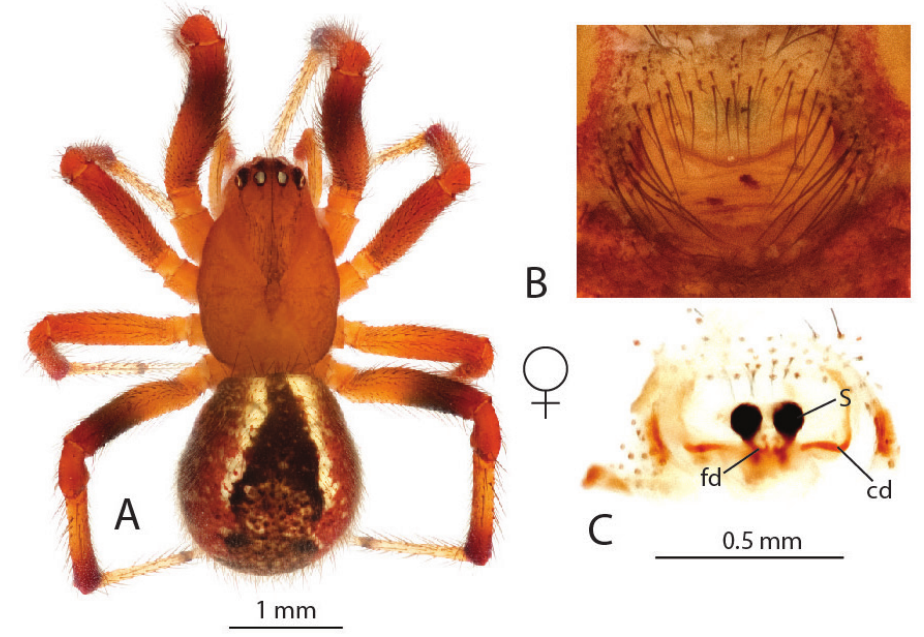
Figure 12. Anelosimus darwini : A female dorsal B epigynum, ventral C epigynum cleared,